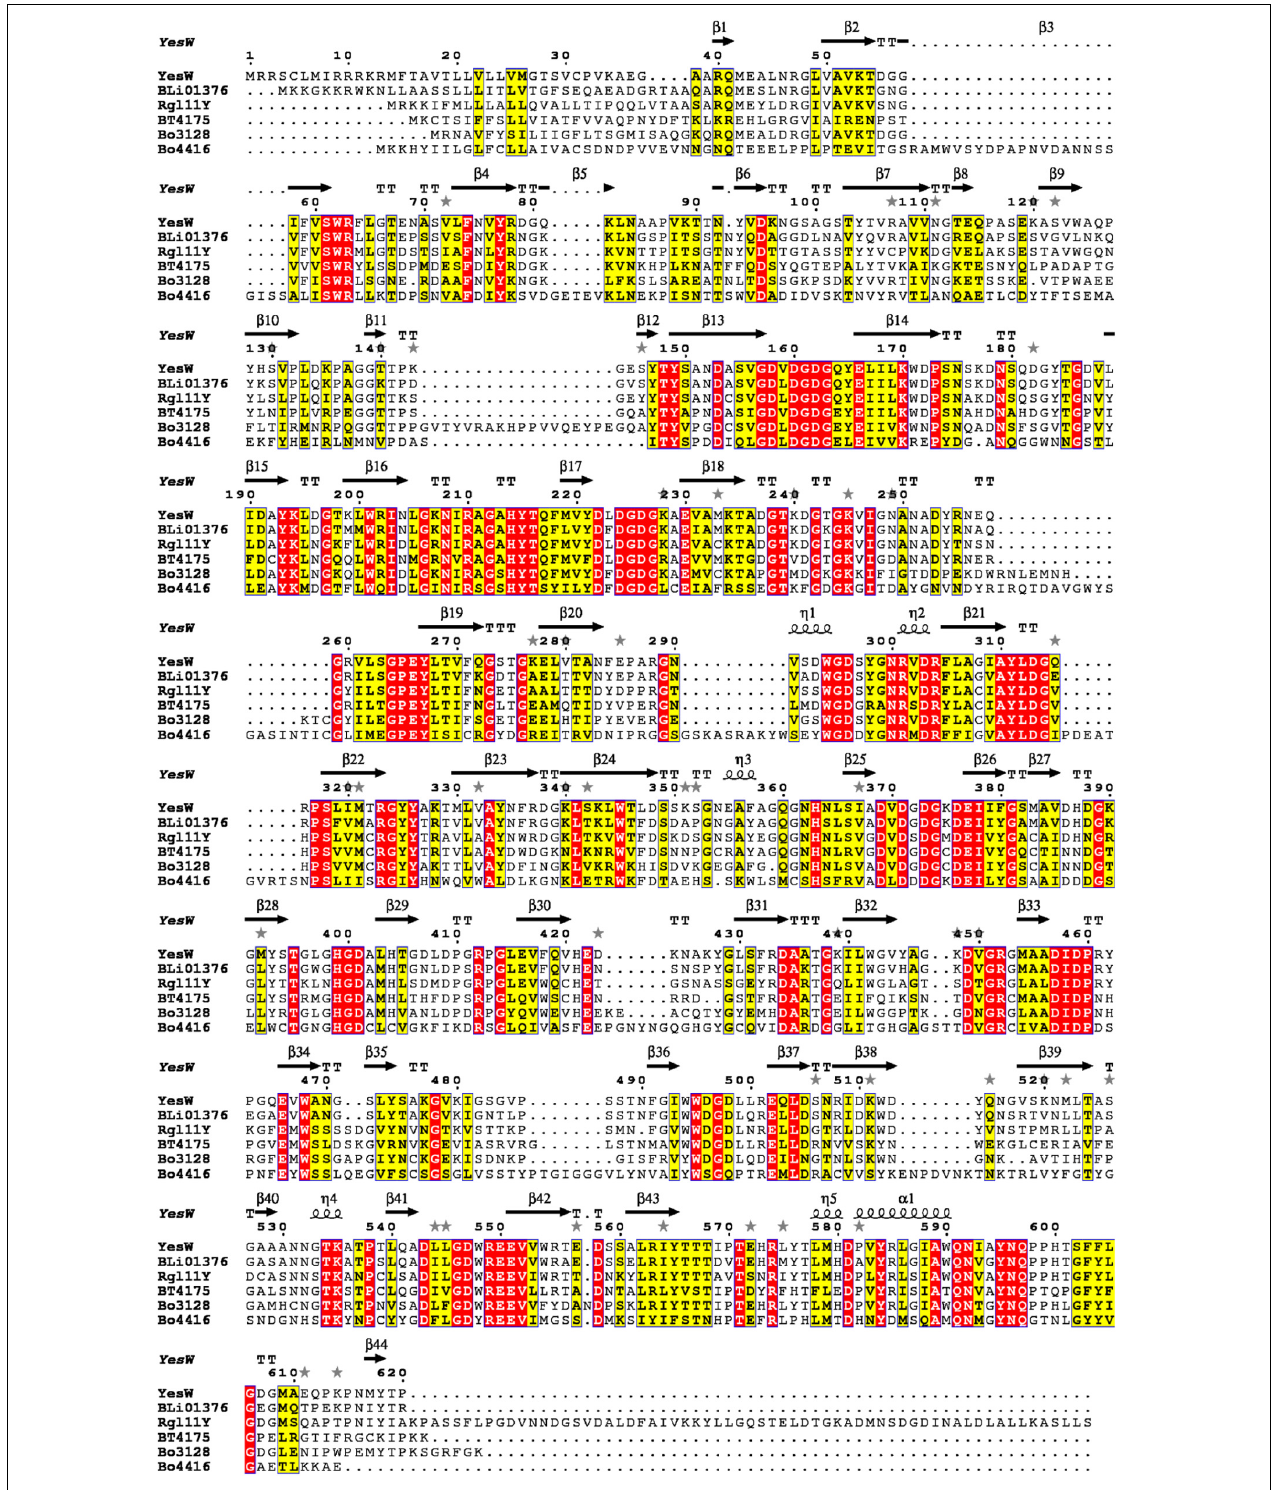
FIGURE 1 | Multiple sequence alignments of Bo3128 and Bo4416 with known PL11 family endo-RGLs in the CAZy database from various microorganisms. GenBank accession numbers of the corresponding amino acid sequences are AAU40280.1 (BLi01376 from Bacillus licheniformis DSM 13), CAB12524.1 (YesW from Bacillus subtilis subsp. subtilis str. 168), ACL75117.1 (Rgl11Y from Ruminiclostridium cellulolyticum H10), and AAO79280.1 (BT4175 from Bacteroides thetaiotaomicron VPI-5482).